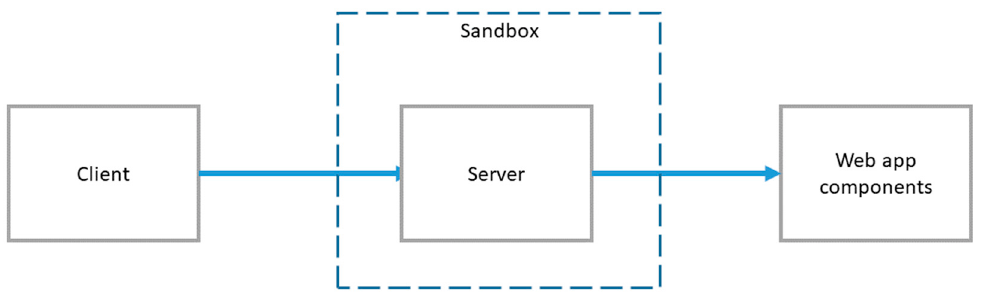
Figure 7. Descriptive overview of Server Sandbox pattern.